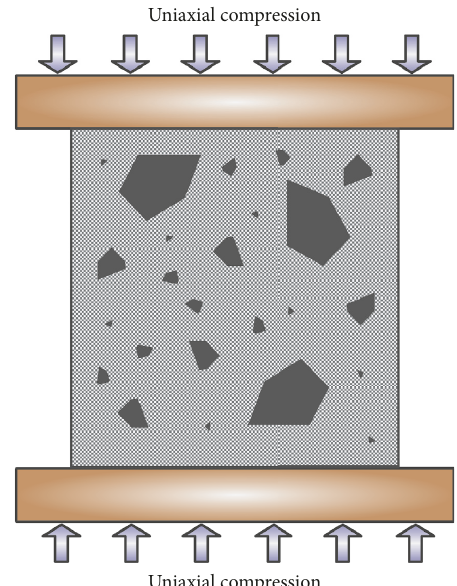
Figure 10: Compressive loading model.